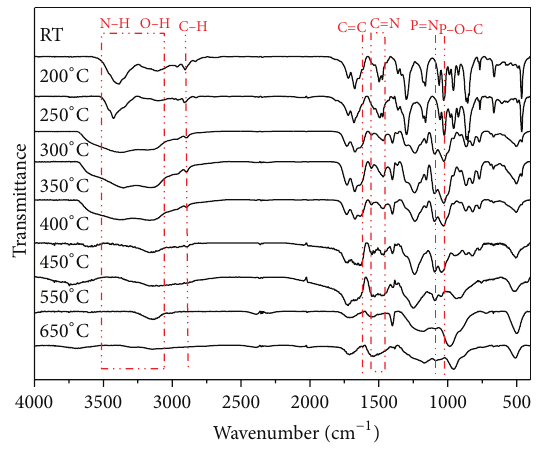
Figure 5: FTIR spectra of MPP/PEPA treated at different tempera- tures for 15min. Note: the mass ratio of MPP to PEPA was 1:2.